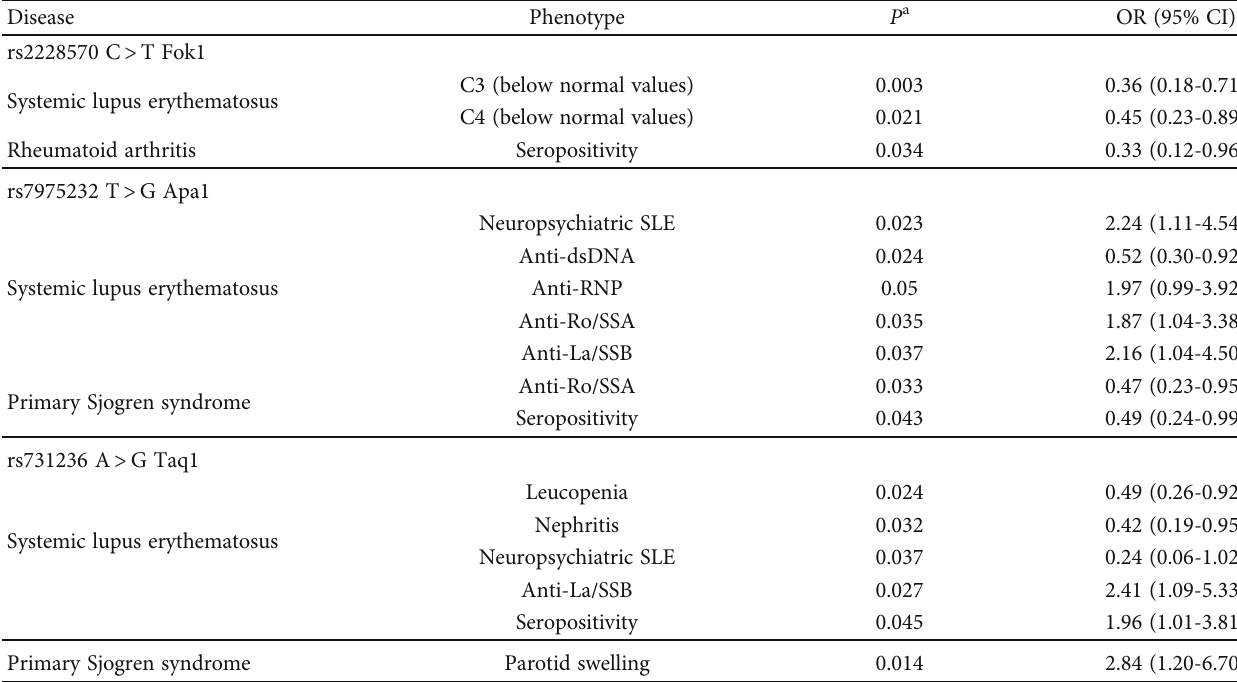
Table 2: Association between disease phenotypes and studied